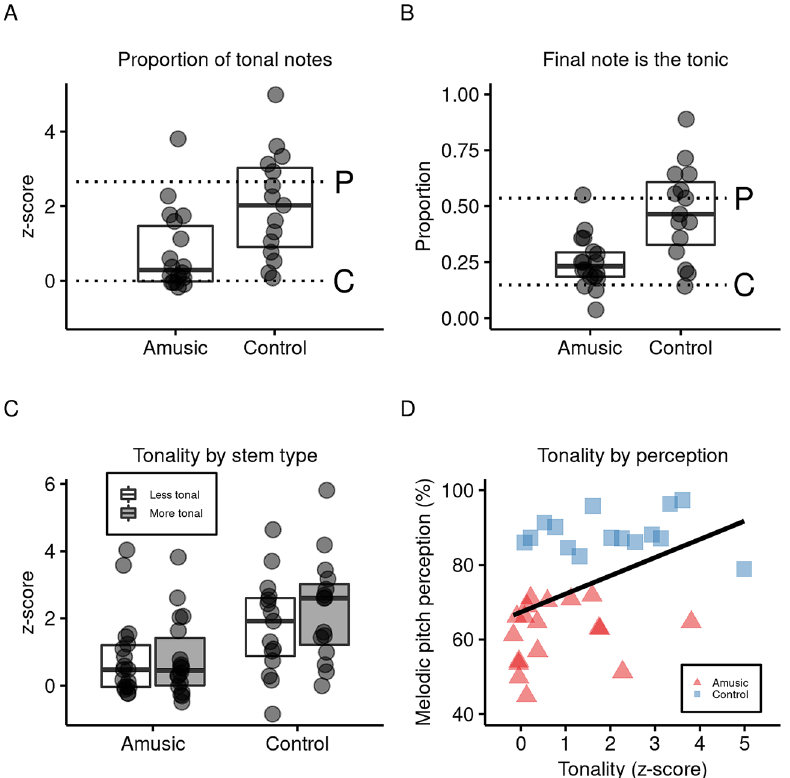
Figure 3. Tonality of improvised songs. ( A ) shows the z-transformed proportion of tonal notes. Individual data points were calculated as the average of 28 improvisations, which were z-transformed against 1000 randomly generated melodies. The upper dashed line represents the score of a professional baritone singer with 11 years of formal training and 29 years of total singing experience. His data provide a benchmark of proficient singing since the measures are standardized with a clear baseline but no clear ceiling. The lower dashed line represents chance, i.e., z-score of 0. Both groups were above chance and the control group had higher scores than the group with amusia. ( B ) shows the proportion of trials in which the participant ended their improvisation within 50 cents of the tonic determined by the key-finding algorithm. Each value was calculated as an average from 28 improvisations, except in a handful of cases with truncated recordings. The upper dashed line represents the score of a professional singer. The lower dashed line represents chance (0.149), as estimated from over one million random permutations generated over the course of the analyses. Both groups were above chance and the control group had higher scores than the group with amusia. ( C ) shows mean tonality of improvisation as measured by proportion of tonal notes (z-score) according to group and type of stem. An interaction between group and stem was driven by a significant difference between more tonal over less tonal stems in the control group only. All subgroupings of the data (i.e., individual boxplots) were significantly above chance (i.e., z-score of 0). Boxplots display median (line) and 25th and 75th percentiles (box edges). ( D ) shows individual melodic perception scores (see Participants) plotted against the tonality of improvisations. The solid trend line visualizes a significant positive correlation across all